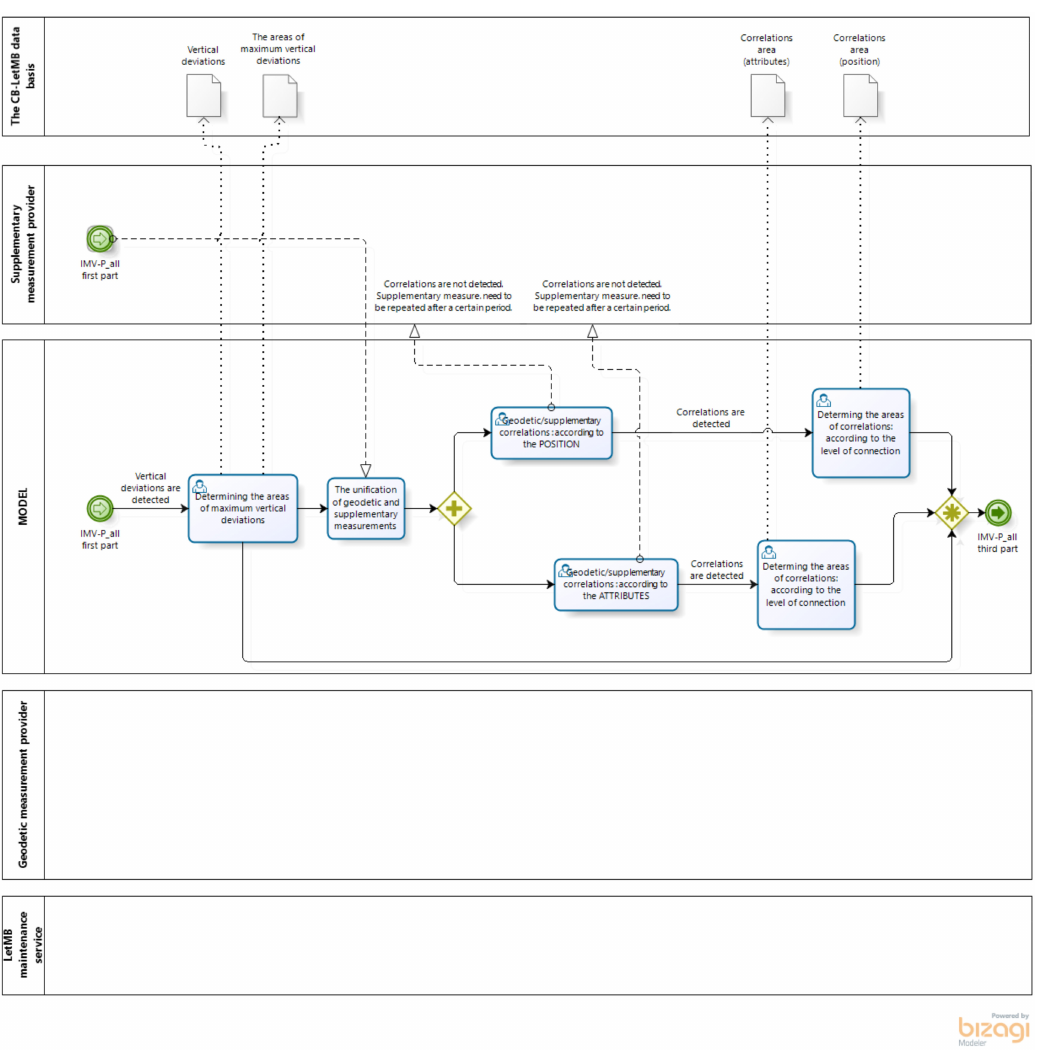
Figure 4. The monitoring process model, sub-process IMV-P_all, part